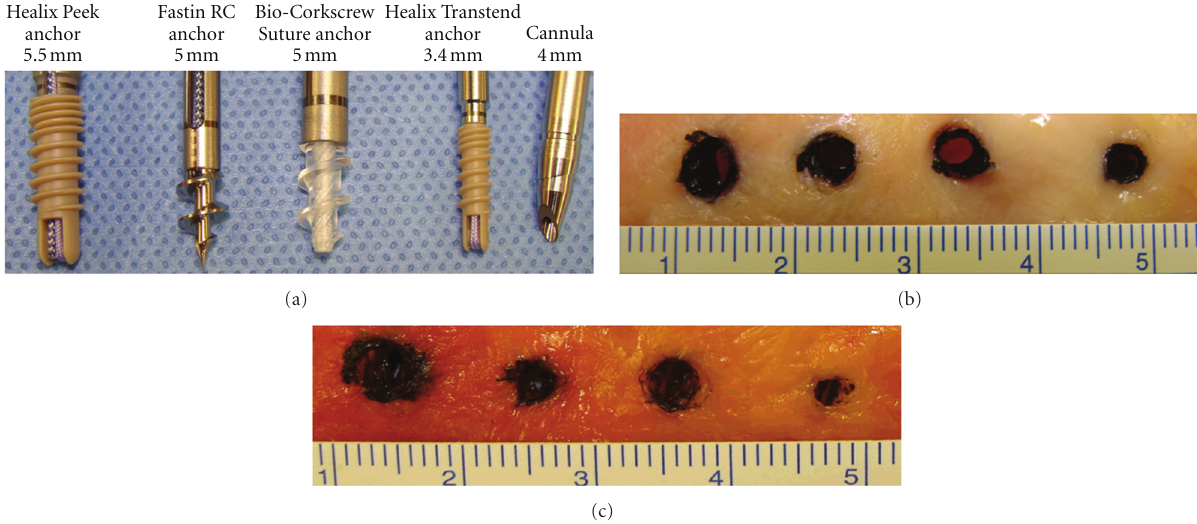
Figure 2: Photographs of anchors and the tendon damages caused by the anchors. (a) Photographs of four types of anchors studied, that is, the Healix Peek, Fastin RC, Bio-Corkscrew Suture, and Healix Transtend (with the Percannula system) anchors. (b) Photographs of tendon damage caused by the four types of anchors. All anchors were inserted through the supraspinatus and infraspinatus tendons without any cannula. (c) Photographs of tendon damage caused by the four types of anchors. The Healix Peek, Fastin RC, and Bio-Corkscrew Suture anchors were inserted through the supraspinatus and infraspinatus tendons without any cannula. The Healix Transtend anchor was inserted through the Percannula system, thus the hole in the tendon was caused by the cannula. The unit of the rulers was cm.